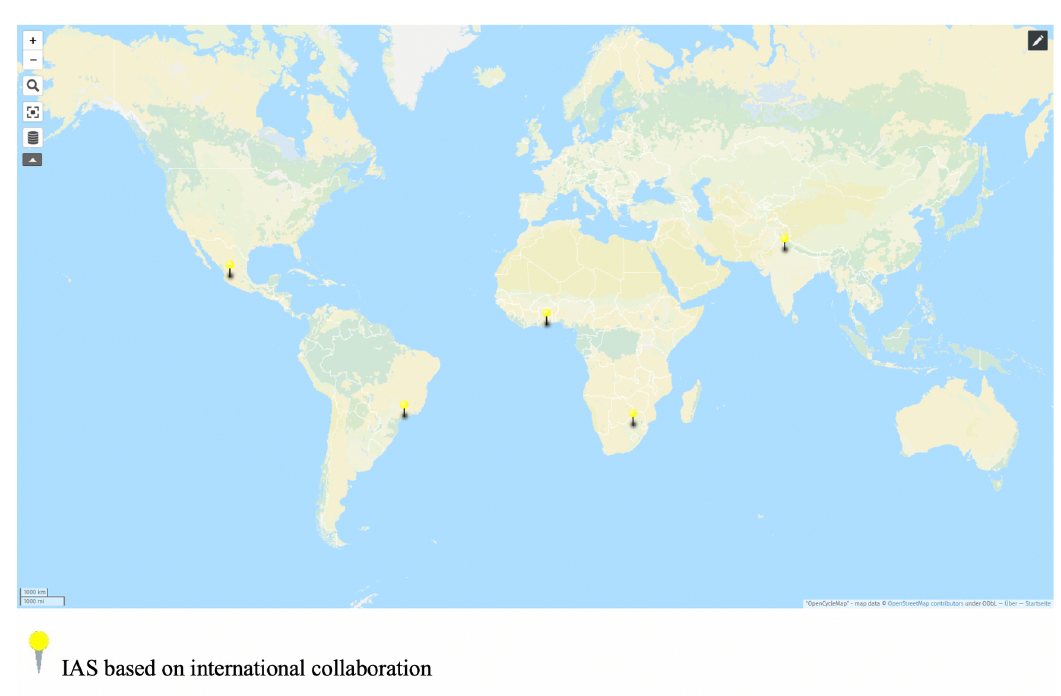
Fig. 4. Generation of the IAS founded in the context of international collaboration Interactive map: